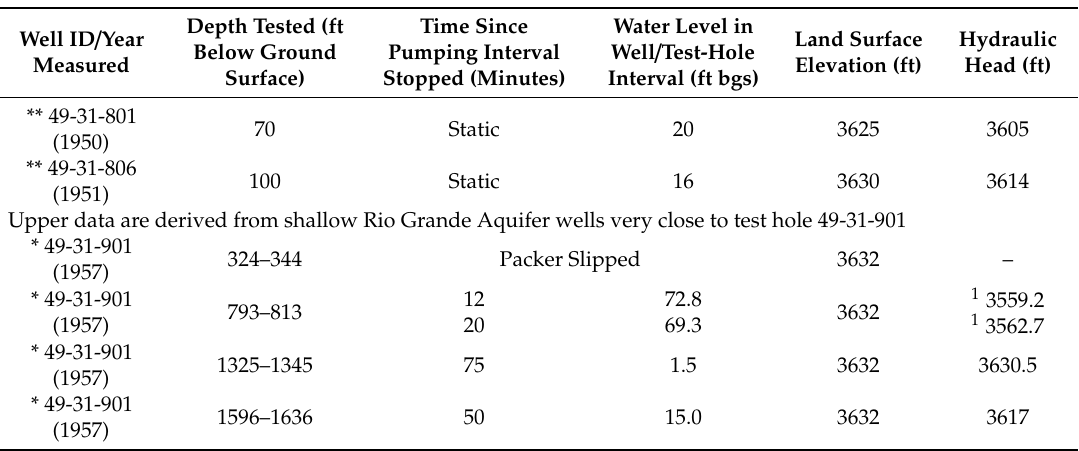
Table 3. Hydraulic head data derived from vertical packer testing of a bore-hole at Texas State #49-31-901 and hydraulic head data from two shallow water wells adjacent to the test hole (Figure 3 shows year 1957 test-hole